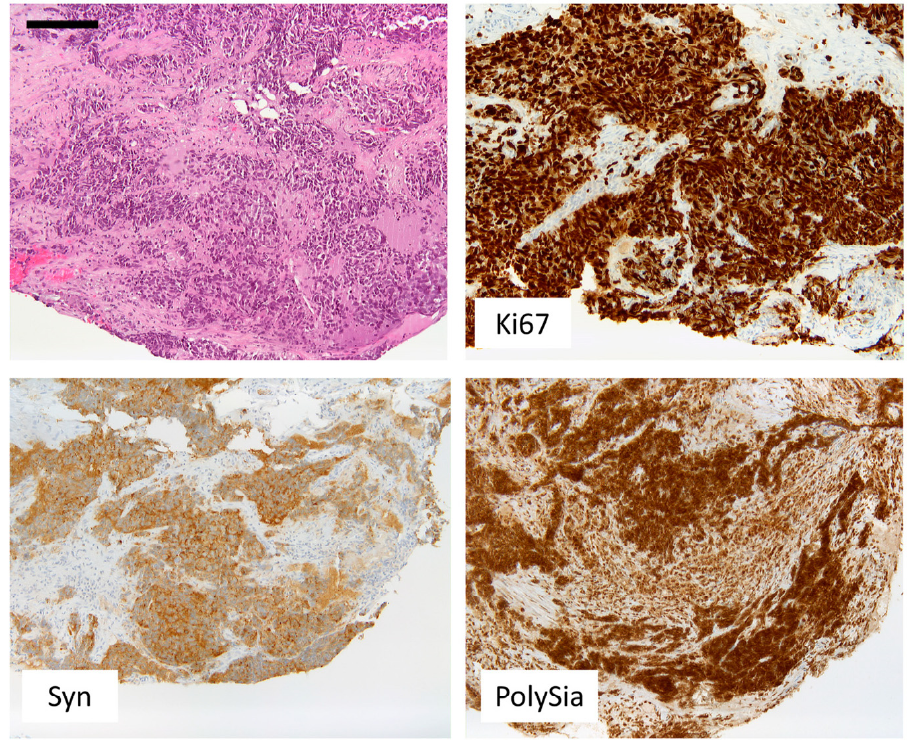
Figure 4. Representative immunohistochemistry of small cell carcinoma (SCLC) with high prolifera- tion index (Ki-67, >95%), positivity for synaptophysin (Syn) and strong expression of polySia-NCAM (PSS). Bar, 500 µ